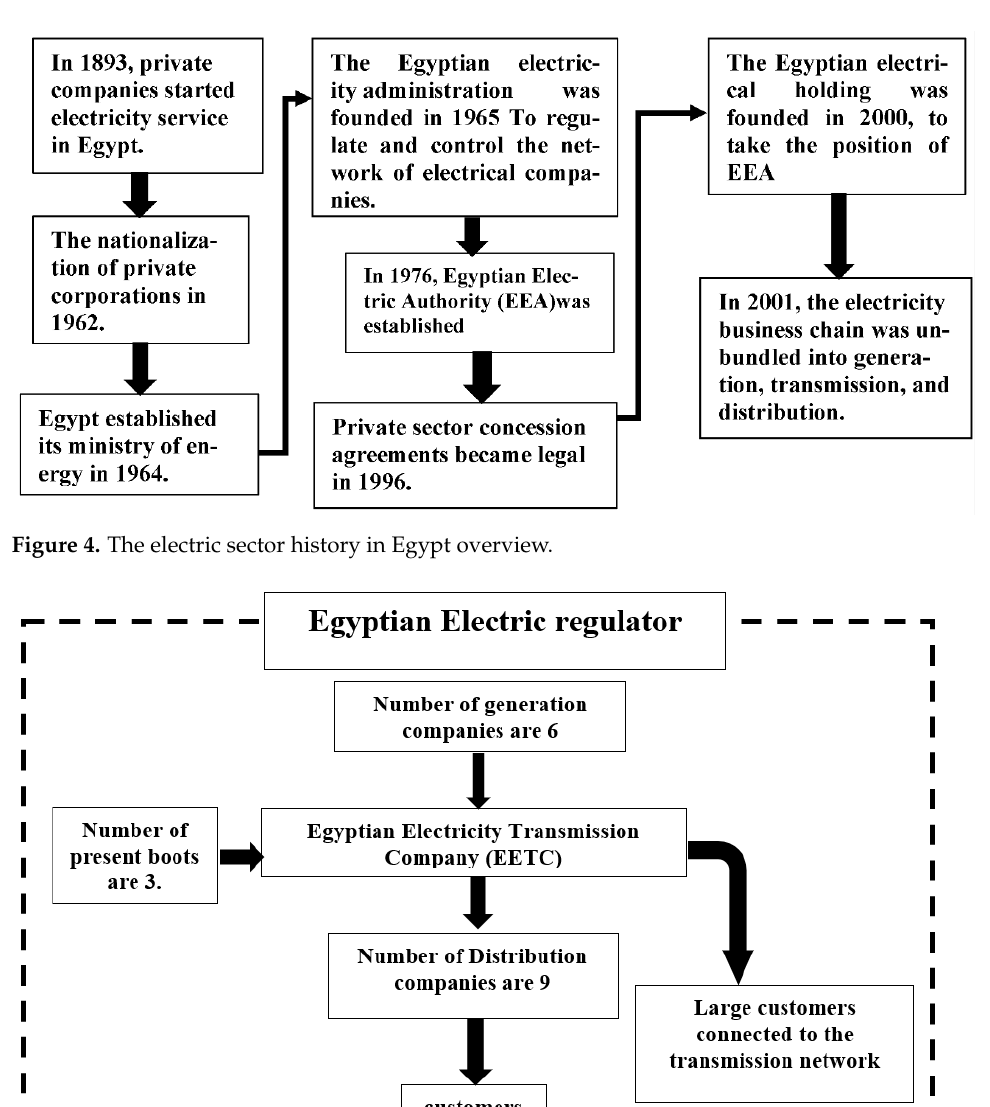
Figure 5. the organizational structure of the electrical sector in Egypt today.